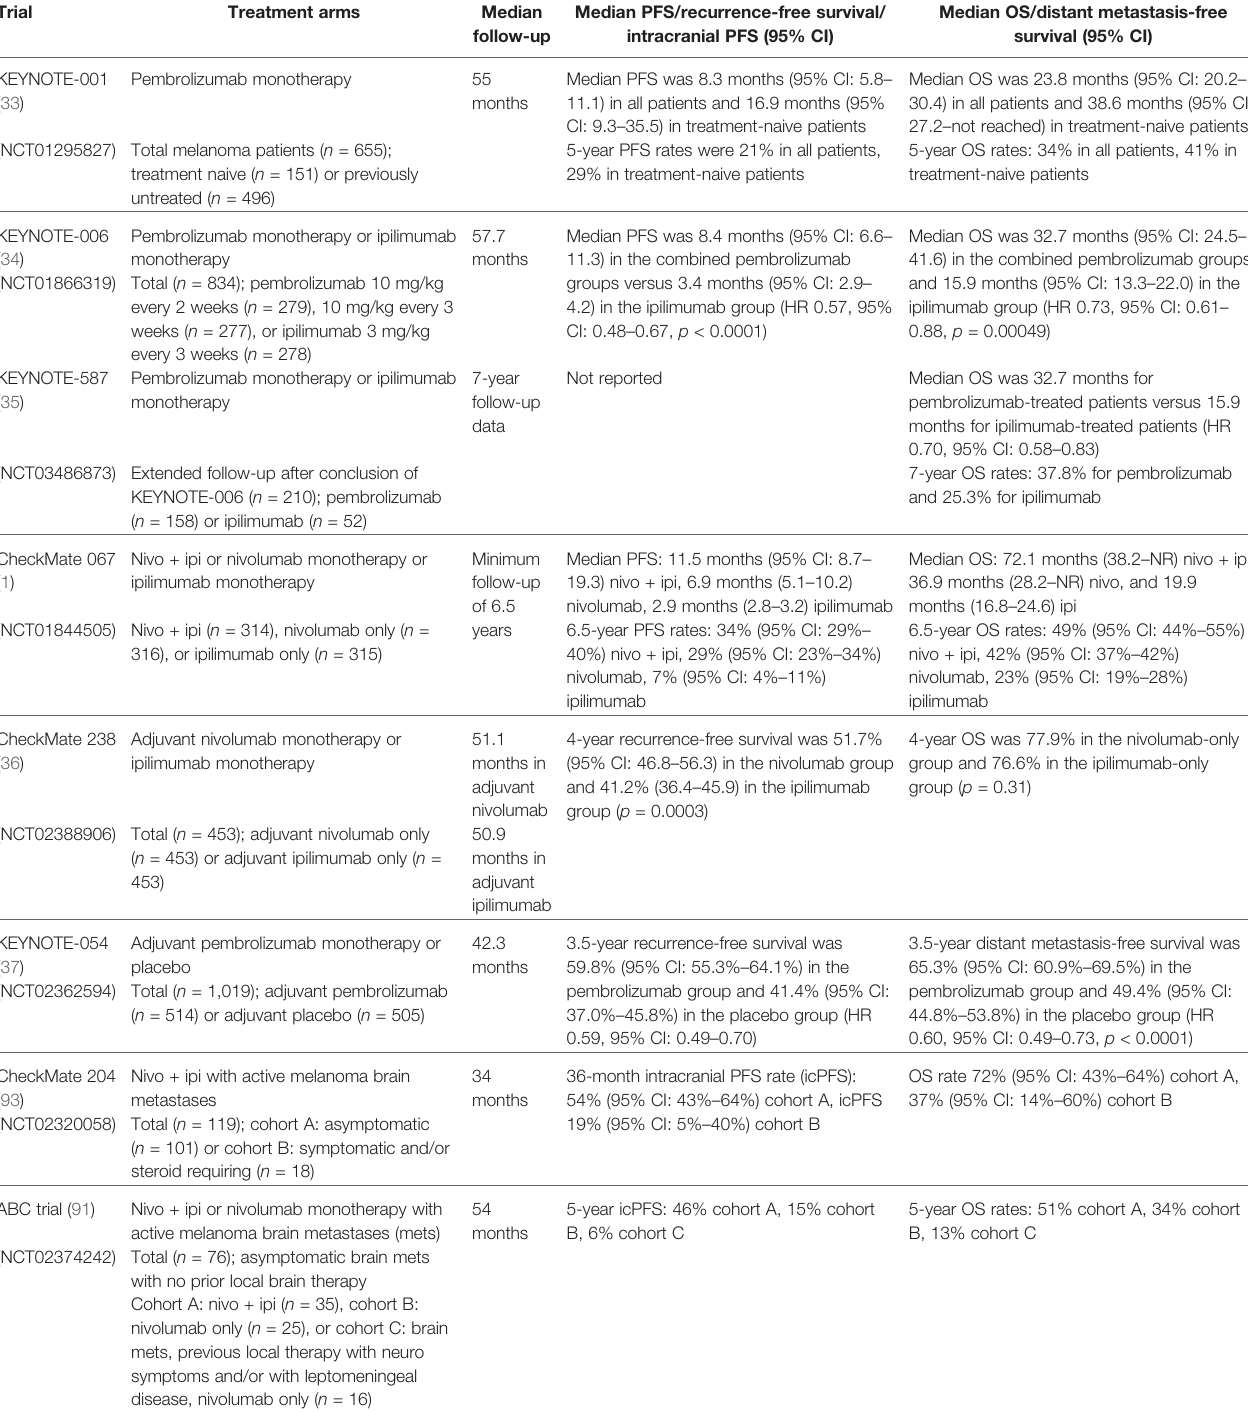
TABLE 1 | Melanoma clinical trials with long-term survival results.